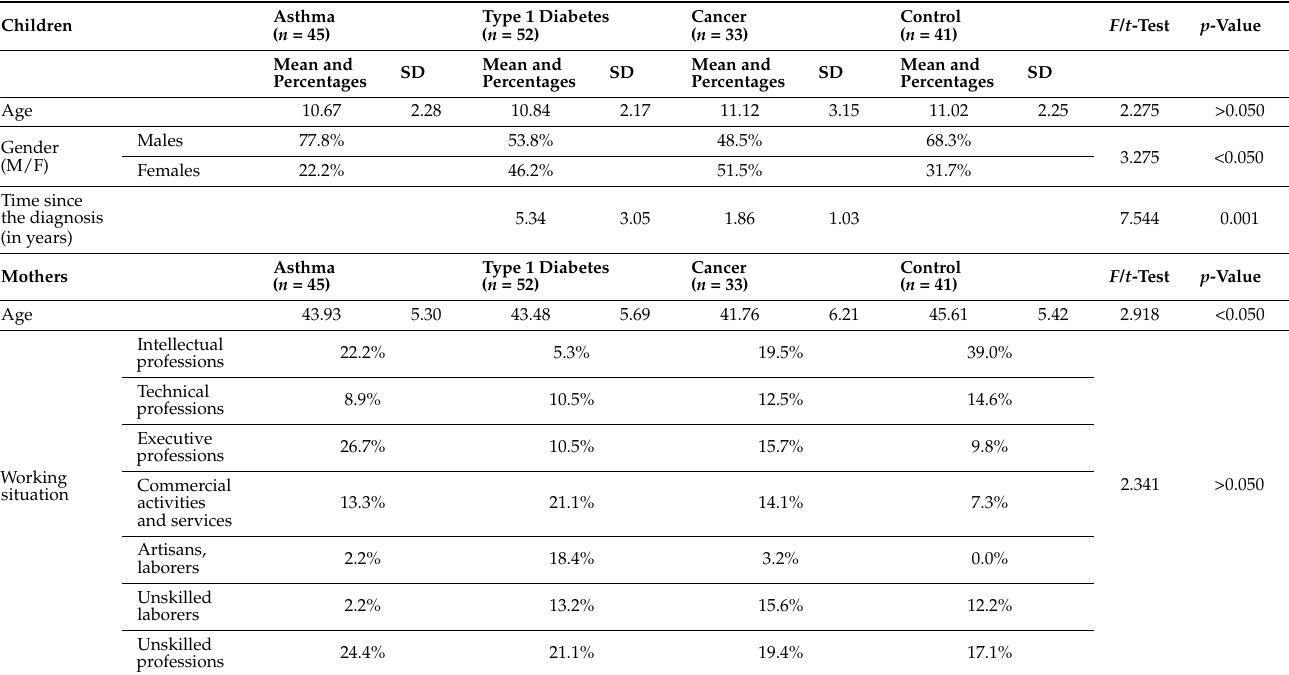
Table 1. Demographics and descriptive variables for the four samples. ANOVA was used for assessing statistically significant differences between groups with respect to age and mothers’ working situation, and Student’s t -test was used for assessing statistically significant differences between groups with respect to the time since the